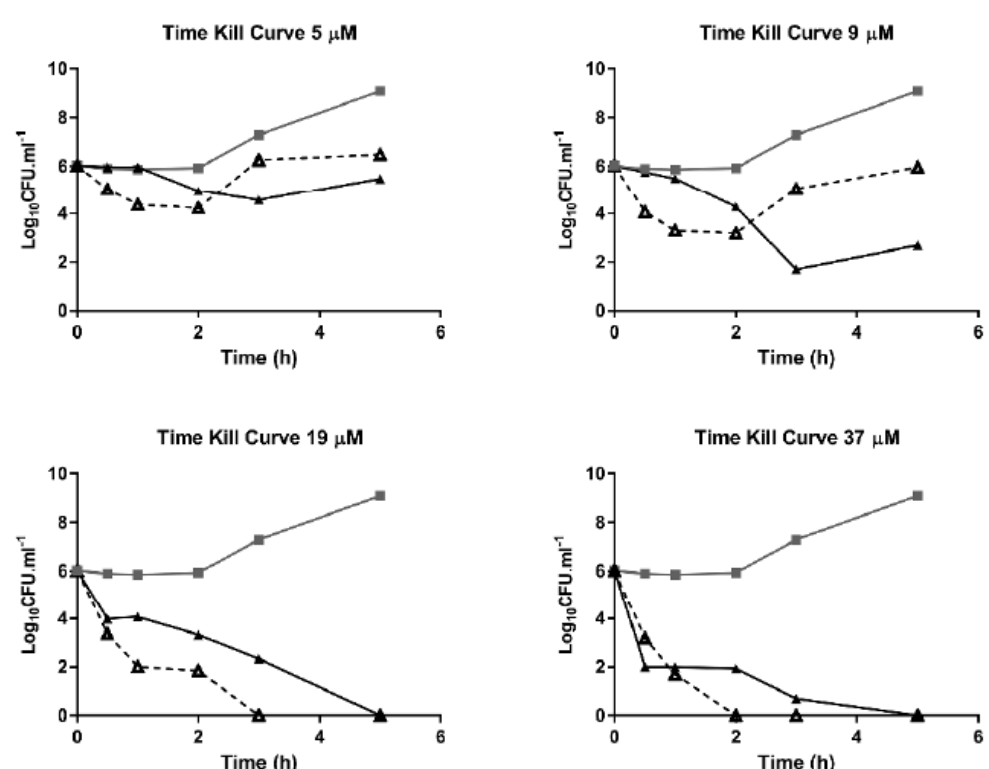
Figure 3. Time-kill plots for different concentrations of peptide, with filled and dashed lines representing Fmoc-PXG and Fmoc-PXG/NO data, respectively. Grey squares represent the control.